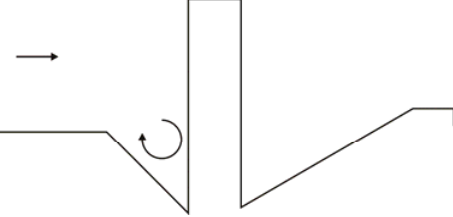
Figure 1. Schematic profile of a cylindrical obstacle in a